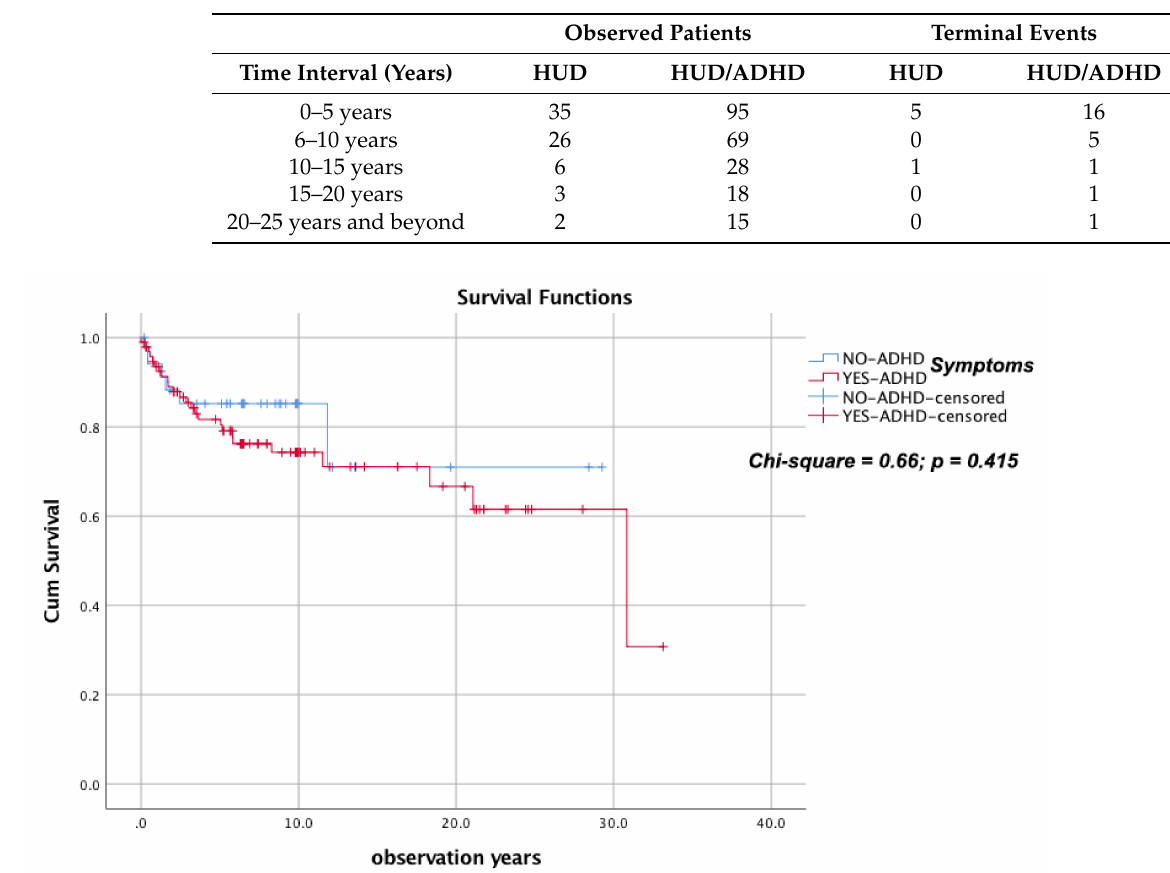
Table 2. Observed patients and terminal events according to the time intervals.